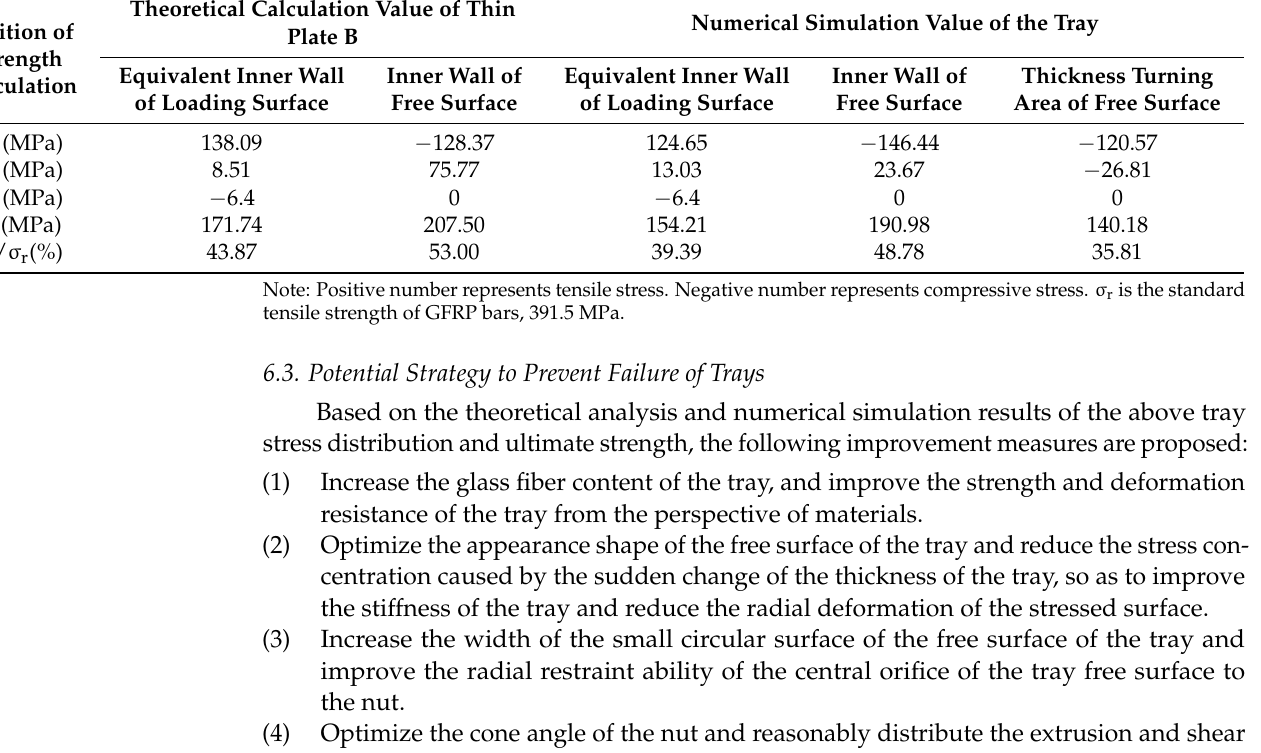
Table 4. Strength calculated values of the